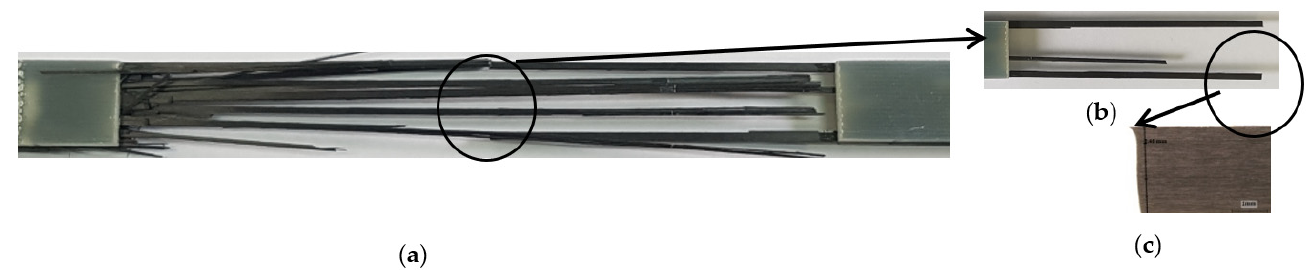
Figure 17. Tensile fracture modes in the 0° orientation of notched coupons with ND-2.4 mm; ( a ) general view; ( b ) two ligaments left after fracture; ( c ) the fracture profile at the notch radius. Table 5. Tensile stresses notched